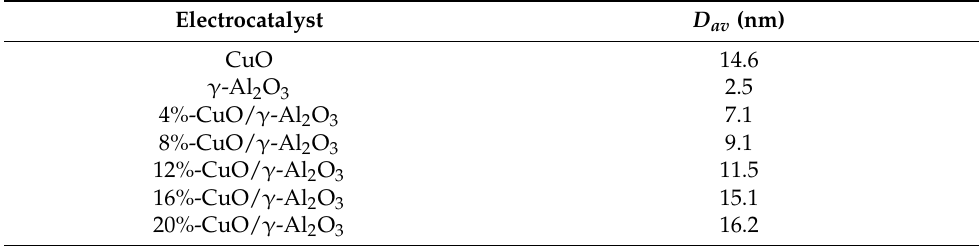
Table 1. Average crystallite size calculated from Scherrer formula.